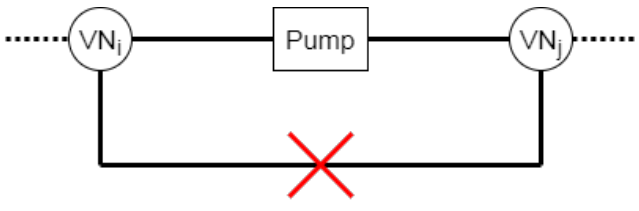
Figure 7. Visualization of the constraint: “The output of an oil pump may not indirectly, by means of two virtual nodes, be connected to the pumps